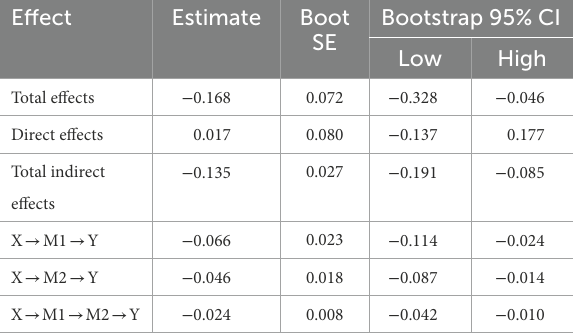
TABLE 4 Total, direct, and indirect effect of HIV-related stigma on HIV self-management though social support and self-efficacy. Effect